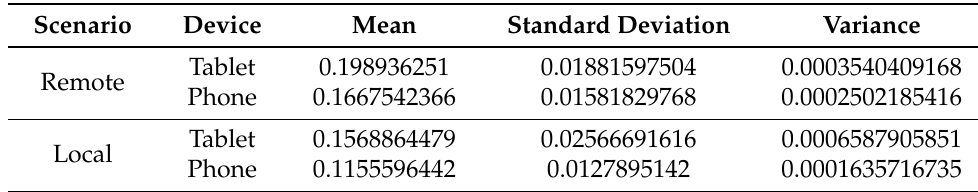
Figure 14. Latency comparison for two different devices on a remote and a local environment. Table 1. Latency of the devices on each scenario